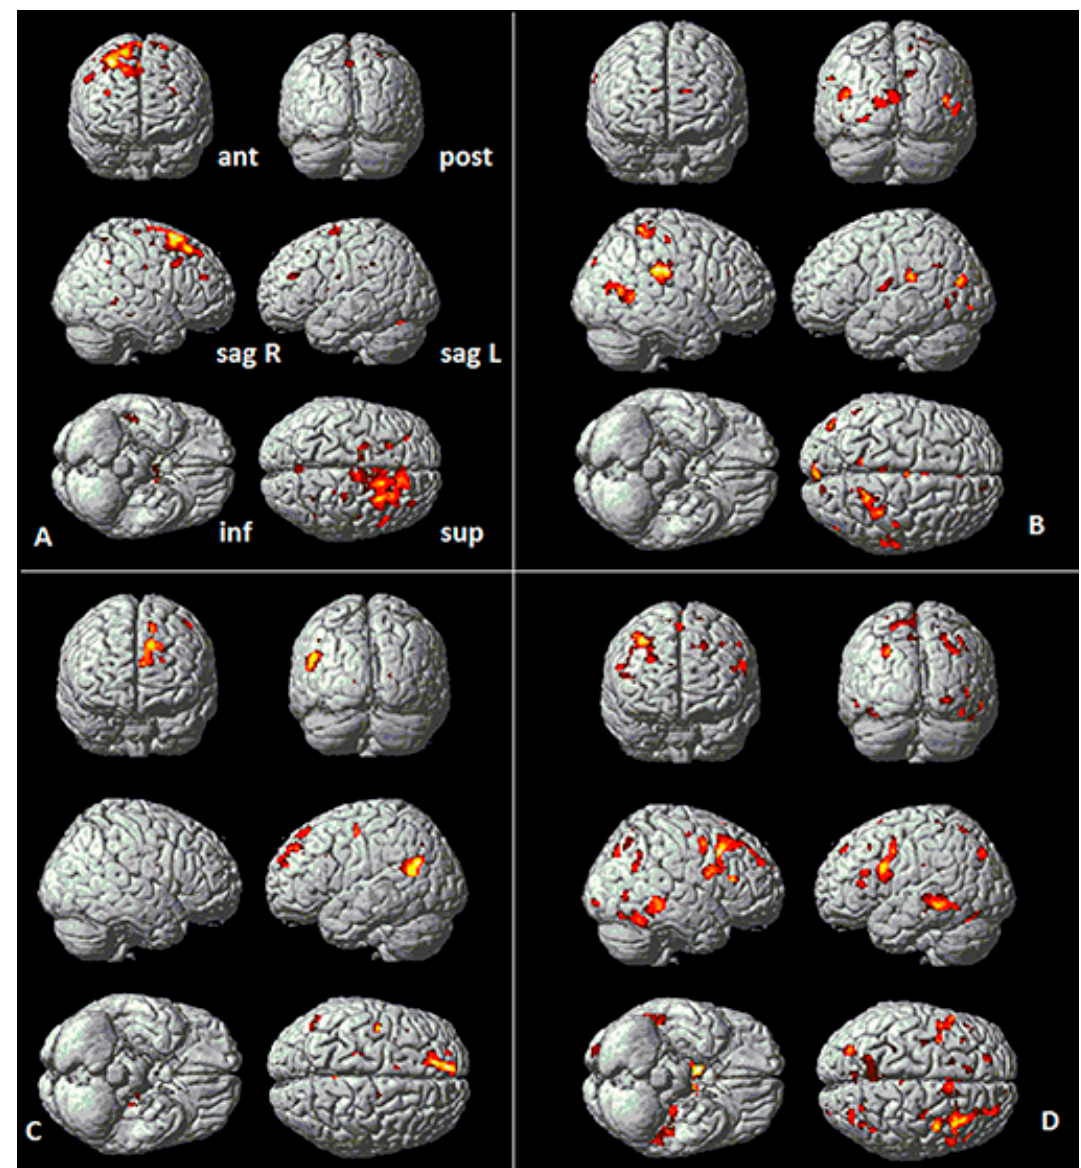
Figure 2. fMRI two-sample t -test Sentences versus Word Overall activation (threshold p < 0.05). Talairach coordinates for each significant regional difference are summarized in Tables 1a,b. Note anatomical views are anterior (ant), posterior (pos), left sagittal (sag L), right sagittal (sag R), inferior (inf), and superior (sup). ( A ) (Top Left), Emotion Type (17 E group vs. 23 Non- E group ). ( B ) (Top Right) Imaginative Type (n = 19 I group vs. 21 Non- I group ). ( C ) (Bottom Left) Logical Type (19 L group vs. 21 Non- L group ). ( D ) (Bottom Right) Material Type (22 M group vs. 18 Non-M group ). Table 1. ( a ) Group analysis (trait versus non-trait) contrast of Emotion/Feeling-Action PO and 282 Imaginative/Intuitive PO ; region by Talairach coordinates, Brodmann area (BA), hemisphere (H) ,and 283 function (significant activations p < 0.05). Note definitions of common functions based on previous 284 work [52]. ( b ) Group analysis (trait versus Non-trait) contrast of Material/Pragmatic PO and 285 Logical/Thinking PO ; region by Talairach coordinates, Brodmann area (BA), hemisphere (H), and 286 function (significant activations p < 0.05). Note definitions of common functions, see [52]. 287 ( a ) Talairach Coordinates BA H Region—Functional Role (Brodmann Areas) ( x, y, z )